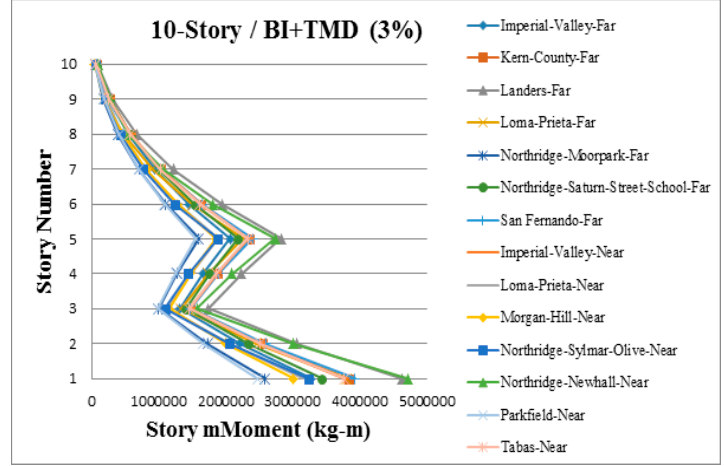
Figure 11. Peak story moments for 10-story base-isolated building with 1 TMD.